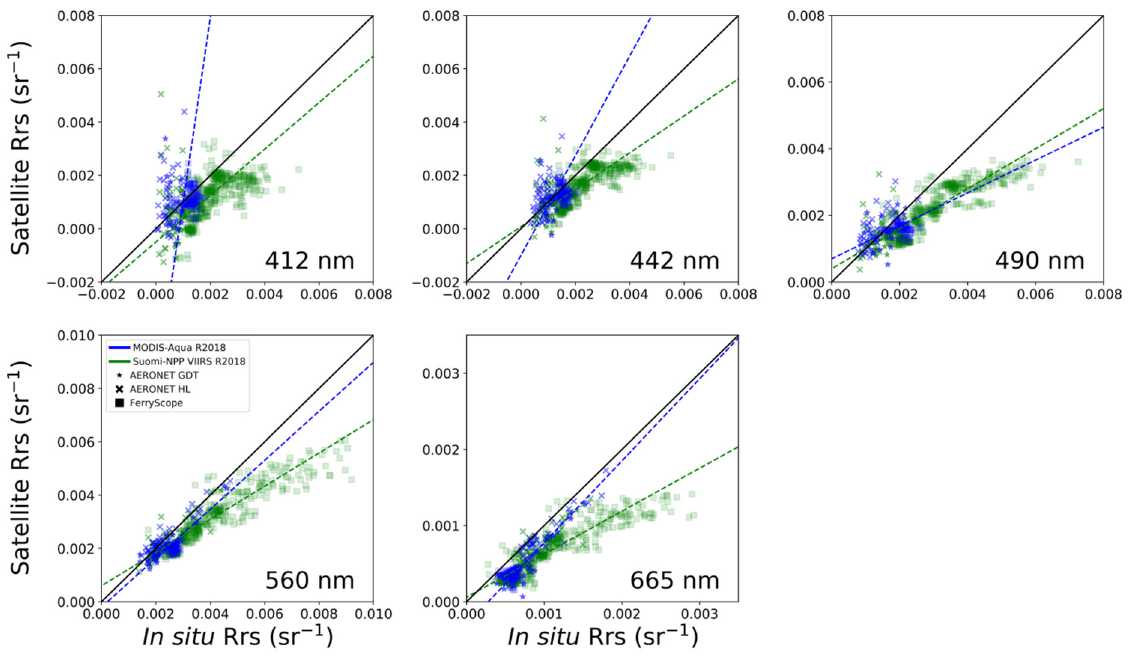
Figure 6. Scatter plots of satellite R rs versus in situ R rs for Suomi-NPP VIIRS (green points and dashed line), MODIS-Aqua (blue points and dashed line) at 412, 442, 490, 560, 665 and 709 nm. Crosses are in situ AERONET-OC HLT R rs , stars are in situ AERONET-OC GDL R rs , squares are in situ Alg@line R rs . Table 4. Statistical results from the comparison of in situ and Suomi-VIIRS and MODIS-Aqua R rs ( λ ) . The metrics were computed using type-II regression for the slope ( S ), intercept ( I ), Pearson correlation coefficient (r), root-mean-square difference (RMSD— Ψ ), the bias ( δ ), bias-corrected root-mean-square error ( Δ ) and the relative percentage difference (RPD). Metrics for the processors with the best performance at each band, are given in bold. N is the number of match-ups, with TOT being the total, GDLT is the AERONET-OC site the Gustav Dalen Lighthouse, HLT is the AERONET-OC site the Helsinki lighthouse and Ferry are the Alg@line data.